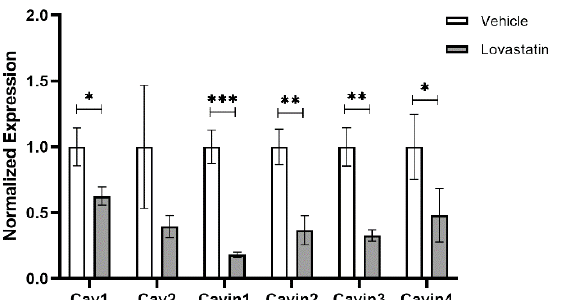
Figure 5. Lovastatin treatment of Outer Root Sheath (ORS) keratinocytes results in downregulation of numerous structural components of caveolae. Primary Outer Root Sheath (ORS) keratinocytes isolated from normal human scalp were treated with 5 µ M Lovastatin for 6 h and then utilized to assess expression levels of structural components of caveolae including Cav1, Cav2, Cavin1 (aka PTRF), Cavin2 (aka SDPR), Cavin3 (aka SRBC) and Cavin4 (aka MURC). Cholesterol disruption by Lovastatin resulted in downregulation of each structural component of caveolae. Error bars correspond to SEM from n = 3 technical replicates with statistical significance assessed using two-way ANOVA with Bonferroni correction for multiple comparisons, * p < 0.05, ** p < 0.01, *** p < 0.001.